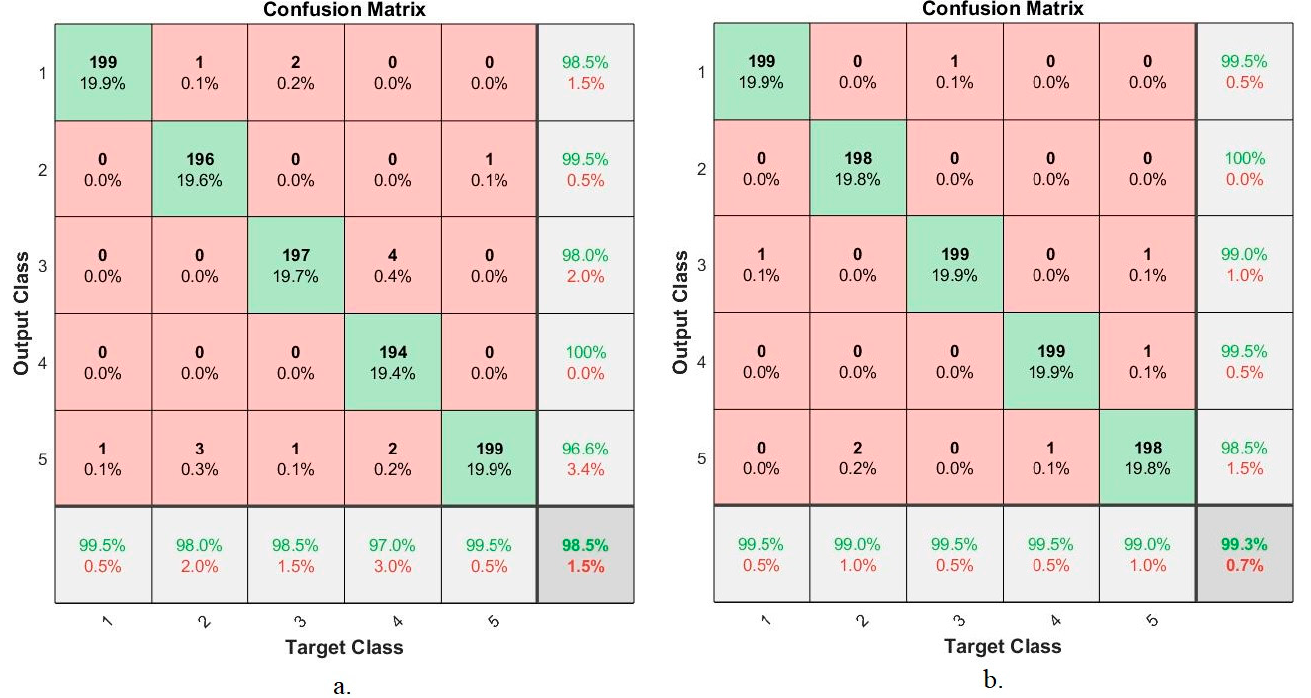
Figure 24. Results of the FFNN for diagnosing lower gastrointestinal diseases based on hybrid features ( a ) GoogLeNet with traditional algorithm and ( b ) AlexNet with traditional algorithm.